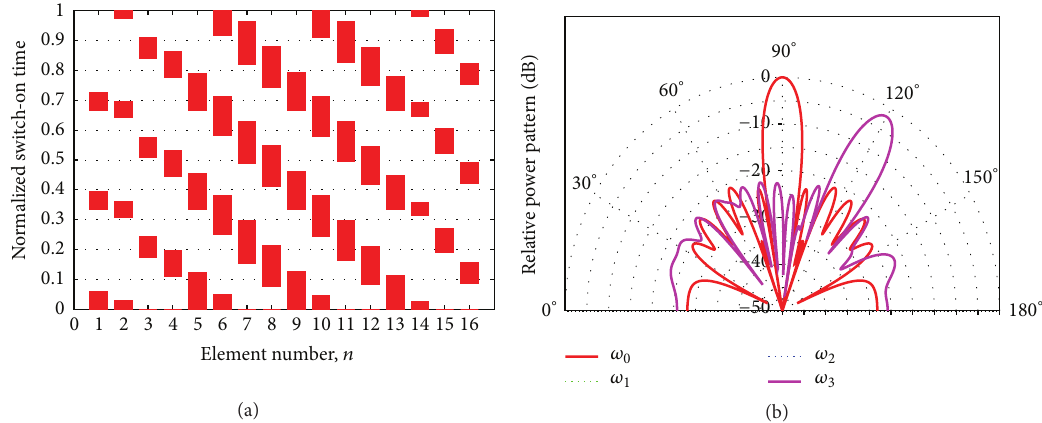
0.10.20.30.40.50.60.70.80.91